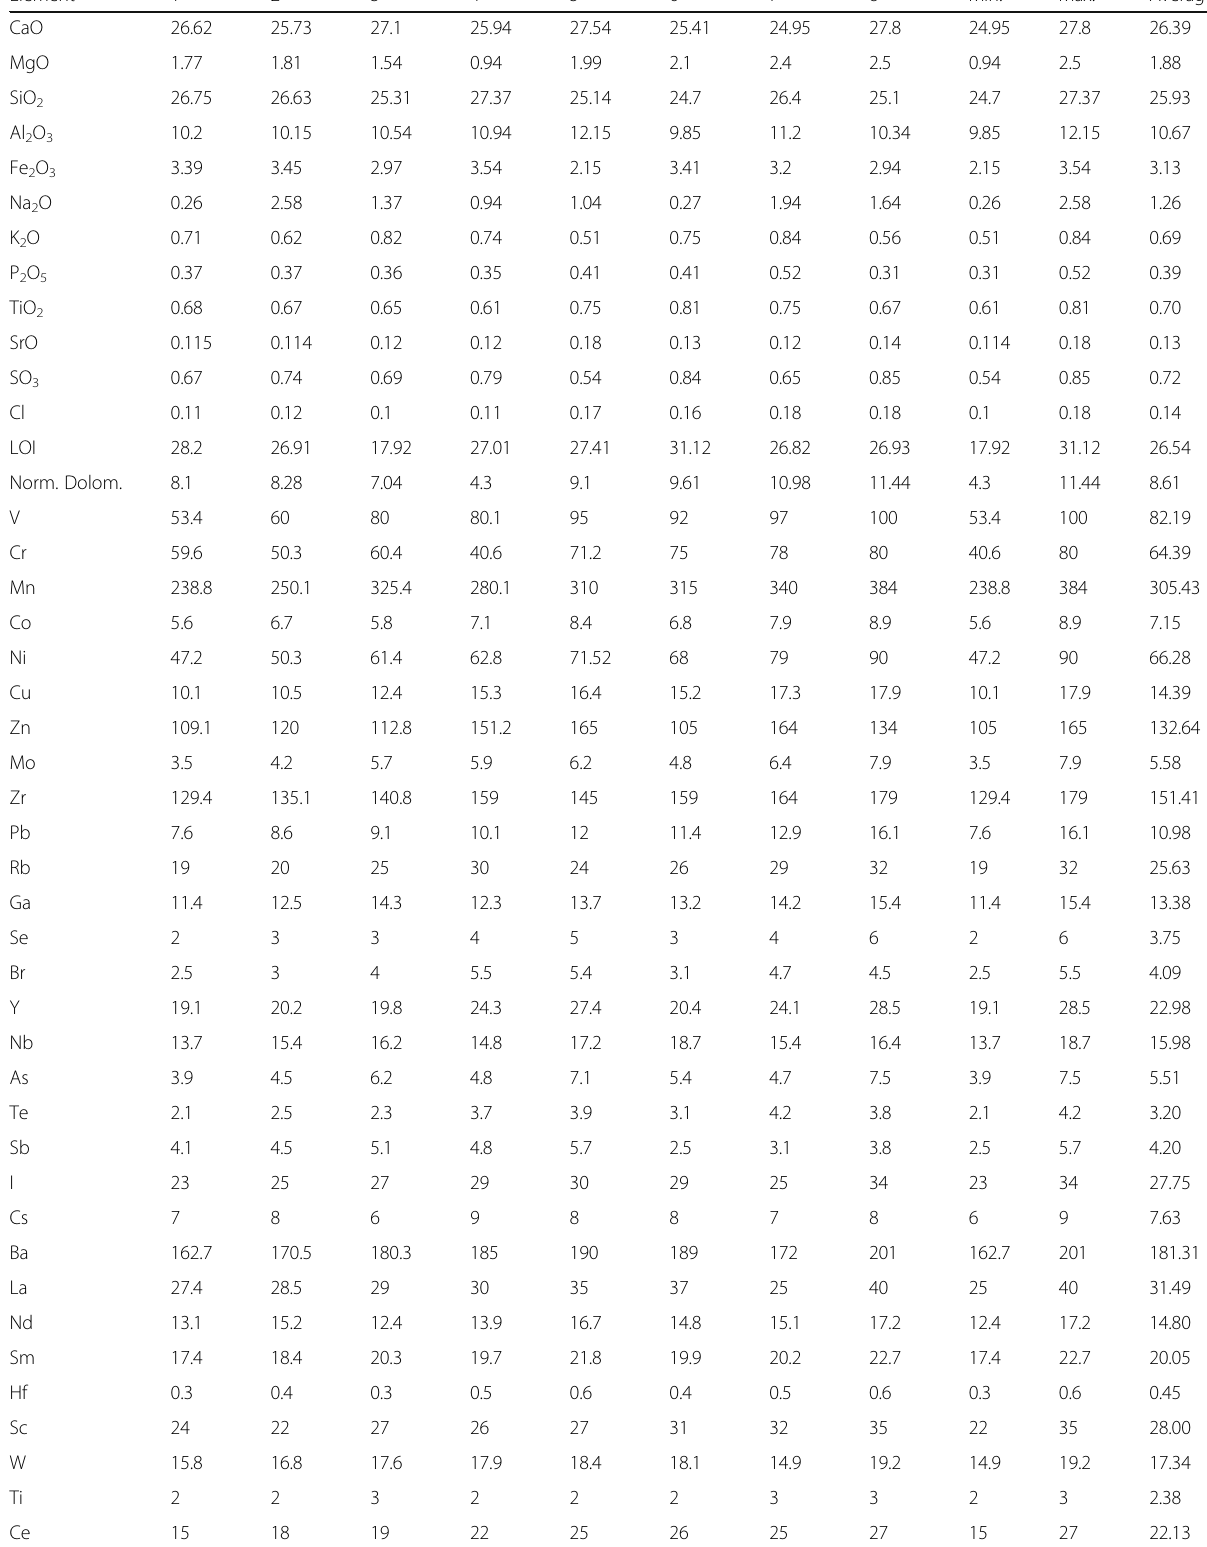
Table 1 Concentration of major (%), trace, and rare earth elements (ppm) of the studied carbonate rocks as well as ratios Element 1 2 3 4 5 6 8 Min. Max. Average CaO